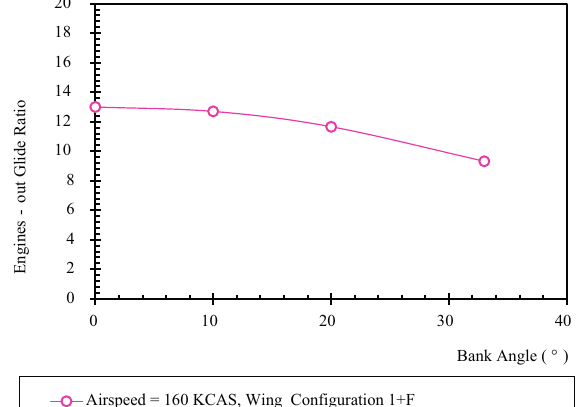
Fig. 2. Predicted engines-out glide ratio for the A320 aircraft during a steady-speed descent (wing configuration = 1 + F, landing gear up, aircraft gross weight = 70.0